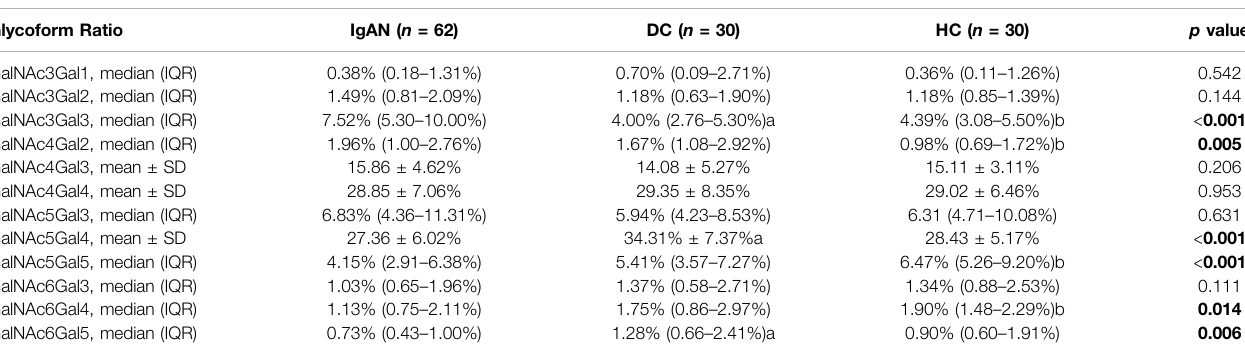
TABLE 2 | Comparison of 12 glycoform ratios of plasma IgA1 HR in the